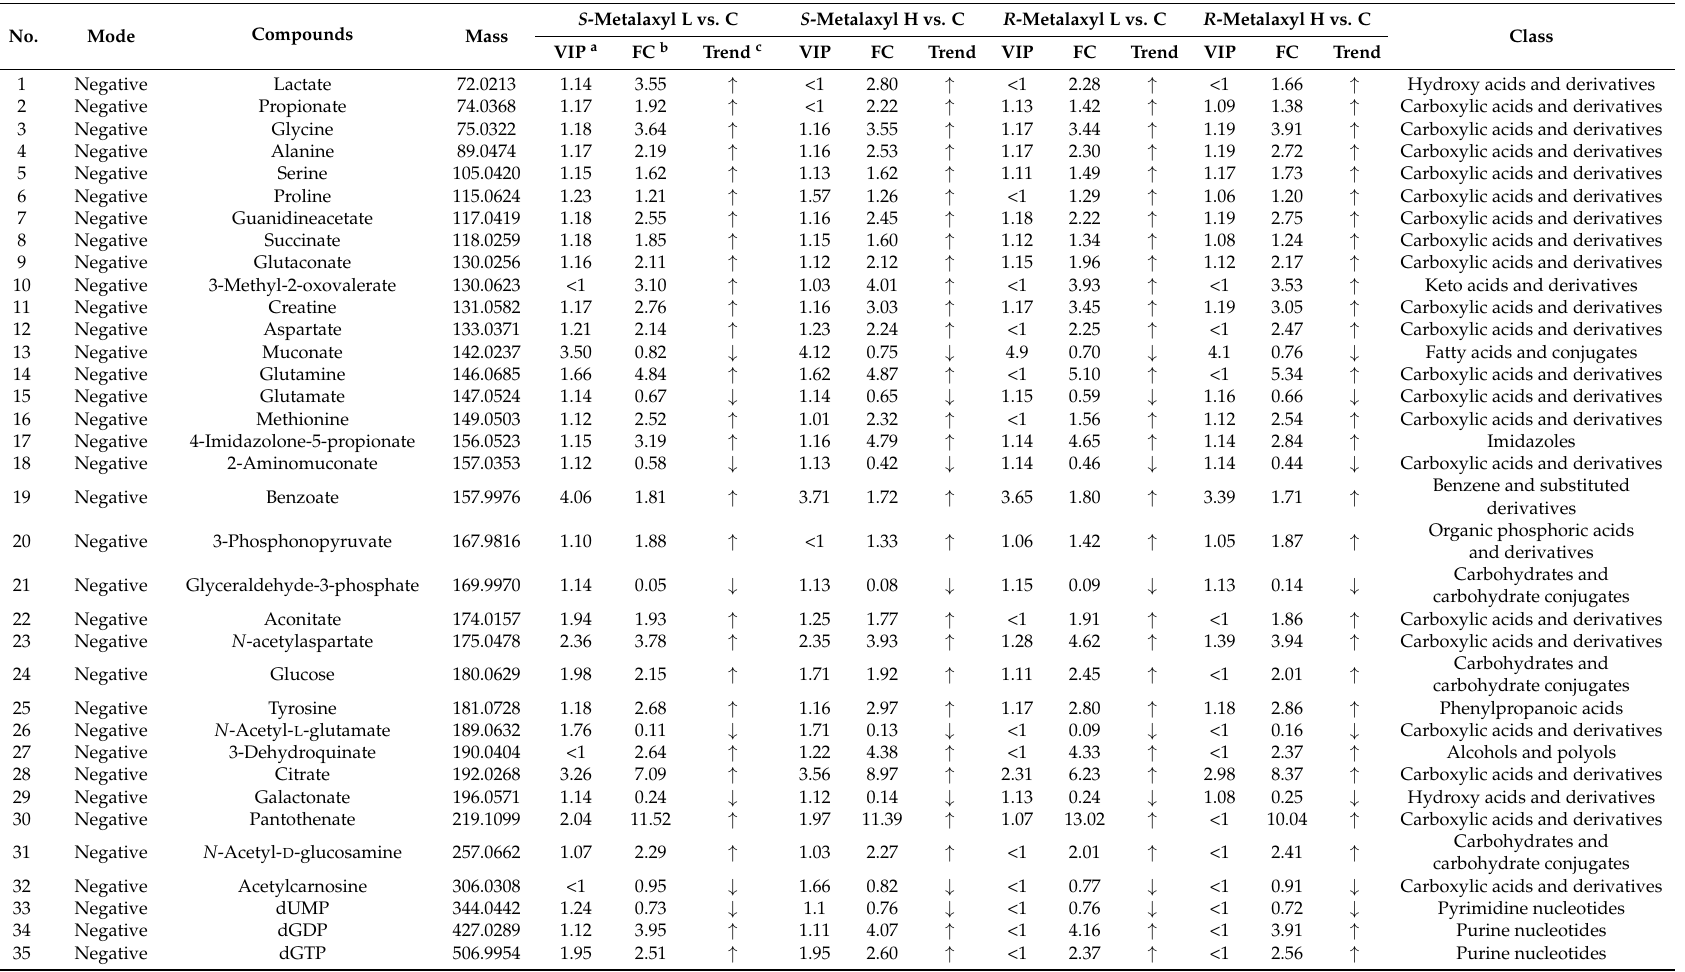
Table 1. Significant changed metabolites induced by R -metalaxyl and S -metalaxyl in MCF-7 cells. C, Control group; L, Low-dose group; H, High-dose group.